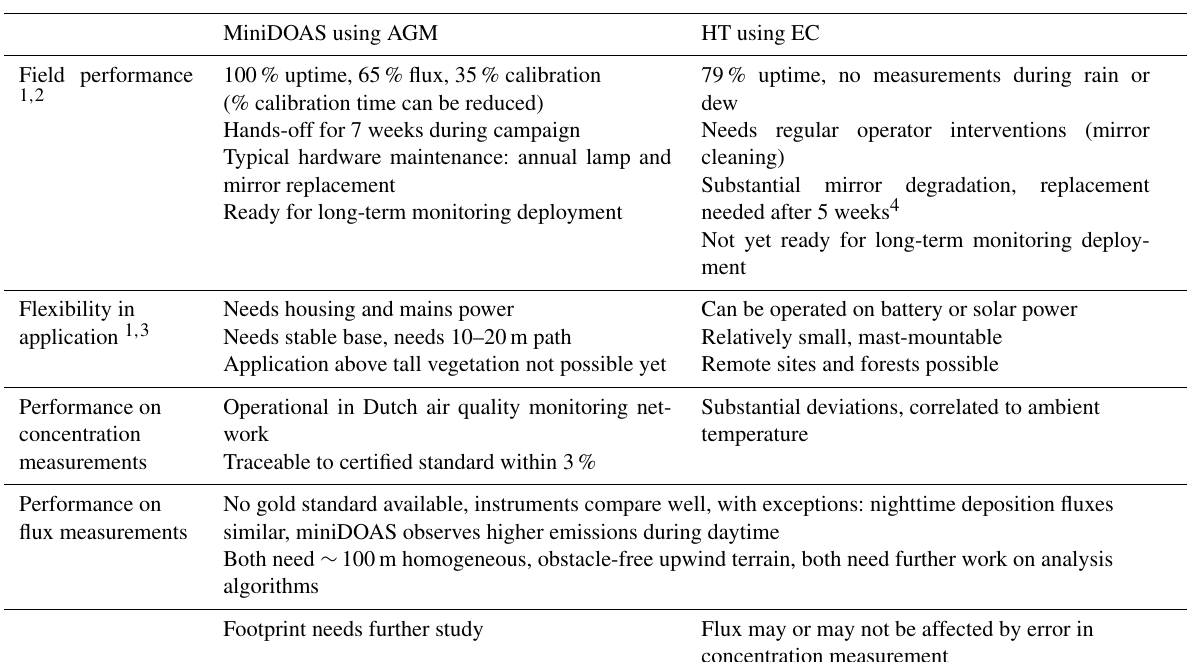
Figure 11. Footprint climatology estimate of the EC measurements ( z = 2 . 8m ) for (a) all wind sectors and (b) the green and light green wind sectors. The red curves are at 10% footprint contour lines. Background map data: Microsoft, CNES Distribution Airbus DS. Table 1. Overview of the main differences, strengths and weaknesses of the two instrument set-ups